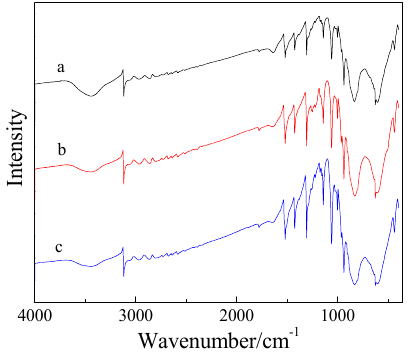
Figure 7. FT-IR spectra of fresh catalyst 1 (a) and used one in cyclooctene epoxidation (b) and used one in 1-octene epoxidation (c).